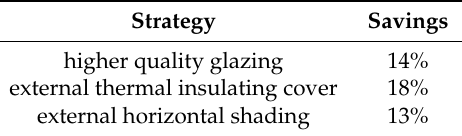
Table 2. Energy savings for three different